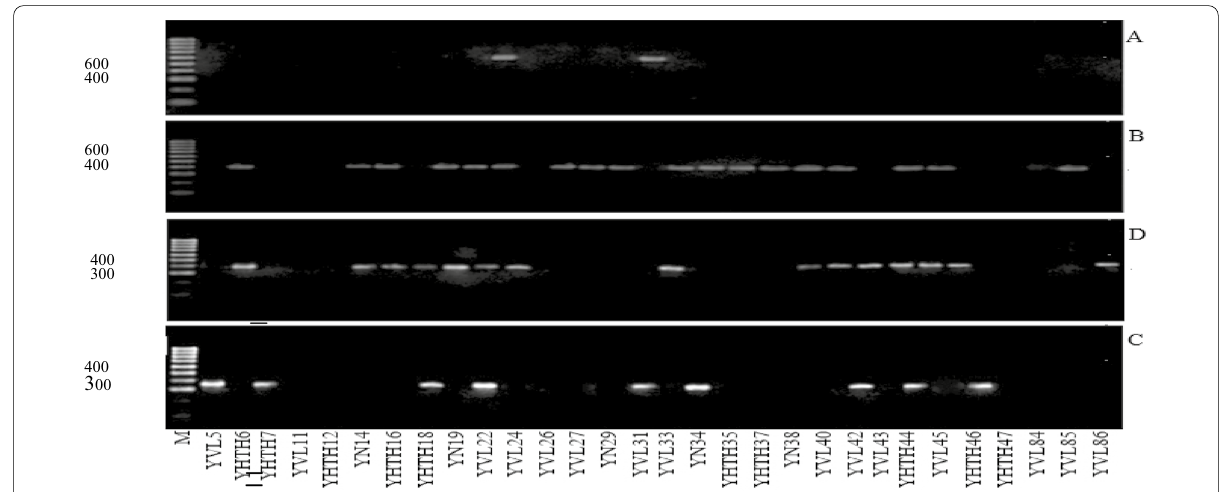
Fig. 3 Electrophoresis determination of toxin gene. M: DNA mass scale (100 bp to 1000 bp), Biobase, Meridian Bioscience). a PCR product of gene tdh . b PCR product of gene tlh . c PCR product of the toxR gene and d PCR product of the trh